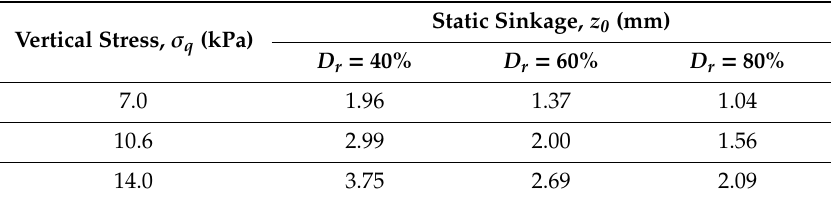
Table 3. Static sinkage of model track experiments.